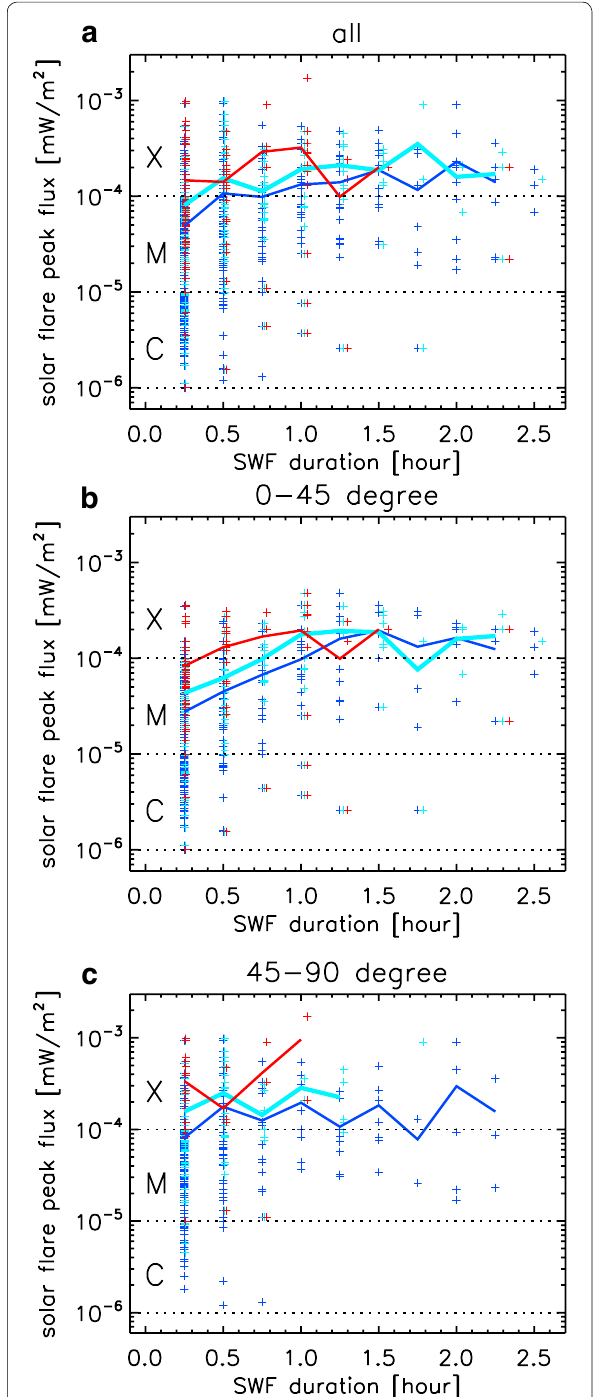
Fig. 6 Scatter plot of solar flare peak flux and SWF duration for SWFs with the criteria of d f min 2.5 MHz (blue lines), d f min 3.5 MHz ≥ ≥ (light blue), and complete blackout (red) for a all cases, and cases with solar zenith angles of b 0–45° and c 45–90°. The solid lines show the median value of the solar flare peak flux in each duration bin